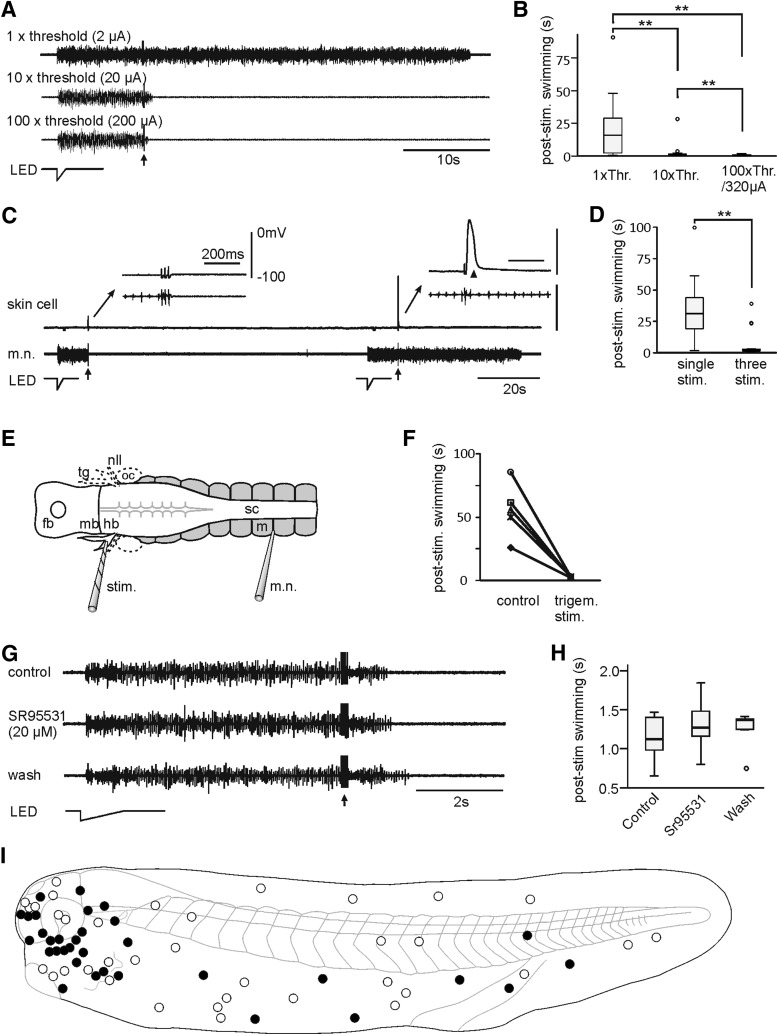
KO responses evoked by electrical skin stimulation. A, Increasing skin stimulation (arrow, five pulses at 30 Hz) intensity shortens swimming in one tadpole. B, Summary of poststimulation swimming lengths at different stimulation current intensities, capped below 320 µA, as shown in A. Swimming thresholds at rest (Thr.) are 2–14 µA. C, Three stimuli at 40 Hz (arrow, 55 µA) evokes a KO response in one tadpole without evoking any skin impulse, while a single stimulus (80 µA) evokes a skin impulse (arrowhead) without shortening swimming. Insets are stretched from time around stimulation. D, Paired comparison of poststimulation swimming lengths as in C showing their dependence on the number of stimuli (n = 29 pairs from four tadpoles, p < 0.001, related samples Wilcoxon signed rank test). A single stimulus always evokes a skin impulse. E, Experimental setup for the direct stimulation of the trigeminal ganglion (tg). A dorsal view of the CNS and some swimming myotomes are shown (fb, forebrain; mb, midbrain; hb, hindbrain; nll, lateral line nerve; stim., stimulation electrode; oc, otic capsule; sc, spinal cord; m, myotome). Dashed lines indicated severed nerves and oc. F, KO responses evoked by stimulating the tg directly after removing nlls (p < 0.01 in each of five tadpoles, two-tailed independent sample t test). G, Bath application of SR95531, a GABAAR antagonist, does not affect the KO response in a tadpole. KO stimuli (arrow) consist of five pulses at 30 Hz. H, Summary of SR95531 experiments in six tadpoles (p > 0.05, related samples Friedman’s two-way ANOVA by ranks). I, KO sites mapped with electrical skin stimuli (10 at 30 Hz). Each site has been applied KO stimuli for more than five times intercalated with trials without KO stimuli. Filled circles indicate KO stimuli shortened swimming (p < 0.05, paired t test or related samples Wilcoxon signed rank test) and empty circles indicate KO stimuli have no effect.